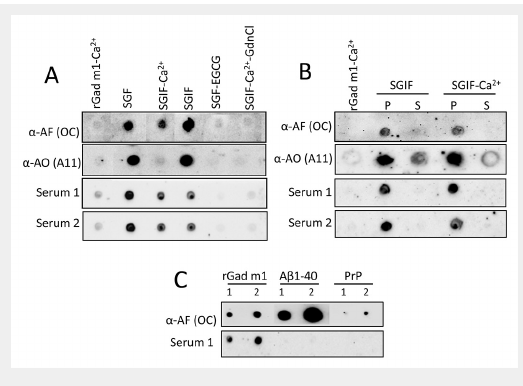
IgE from fish allergic patients sera recognises the rGad m 1 amyloid fibrils. (A) Dot-blot analysis of the immunoreactivity of rGad m 1 species probed with anti-amyloid fibrils (OC), anti-amyloid oligomer (A11) antibodies and with the sera from two fish-allergic patients indicate IgE binding to native amyloid fibrils. Dots correspond to 20 ng of fresh rGad m 1 solution in simulated intestinal fluid (SIF) containing 5 mM Ca 2+ , rGad m 1 fibrillated for 36 h in simulated gastric fluid (SGF) and then diluted 1/50 in SGF, SIF with 5 mM EDTA (SGIF), SIF with 5 mM CaCl 2 (SGIF-Ca 2+ ) and SIF with 5 mM CaCl 2 and 6 M GdnCl. SGF- epigallocatechin gallate (EGCG) corresponds to rGad m1 incubated in the presence of 20 μM EGCG for 36 h and then diluted 1/50 in SGF. ( B ) Separation of soluble (S) and pellet (P) fractions reveal that allergic patients IgE recognise insoluble amyloid fibrils. Fibrils formed at 140 μM protein concentration in SGF were diluted 1/50 in SIF either with 5 mM EDTA (SGIF) or 5 mM CaCl 2 (SGIF-Ca 2+ ) and centrifuged at 100,000xg for 1 h at 4 °C. ( C ) Anti-amyloid fibrils antibody (OC) reacts with amyloid assemblies of rGad m 1, Aβ1–40 and HaPrP 23–231, but IgE from allergic patients sera recognised specifically rGad m 1 fibrils. Labels 1 and 2 correspond to the load of 10 and 20 ng of protein,